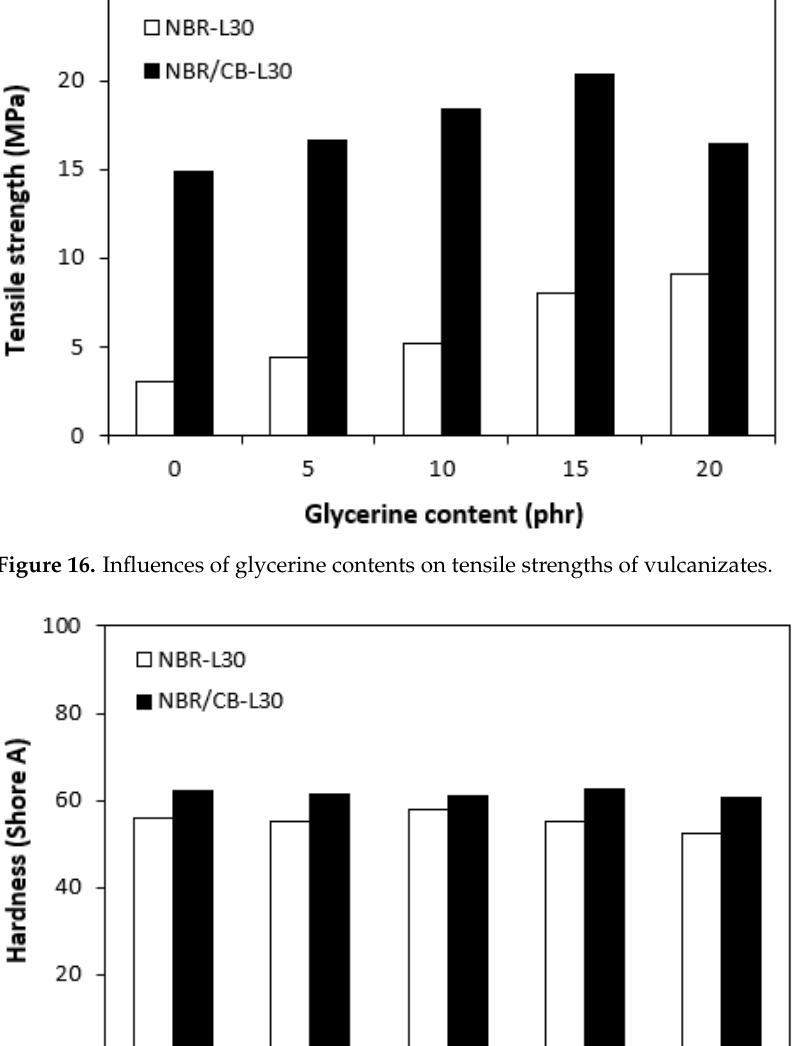
Figure 15. Influences of glycerine contents on elongation at breaks of vulcanizates.